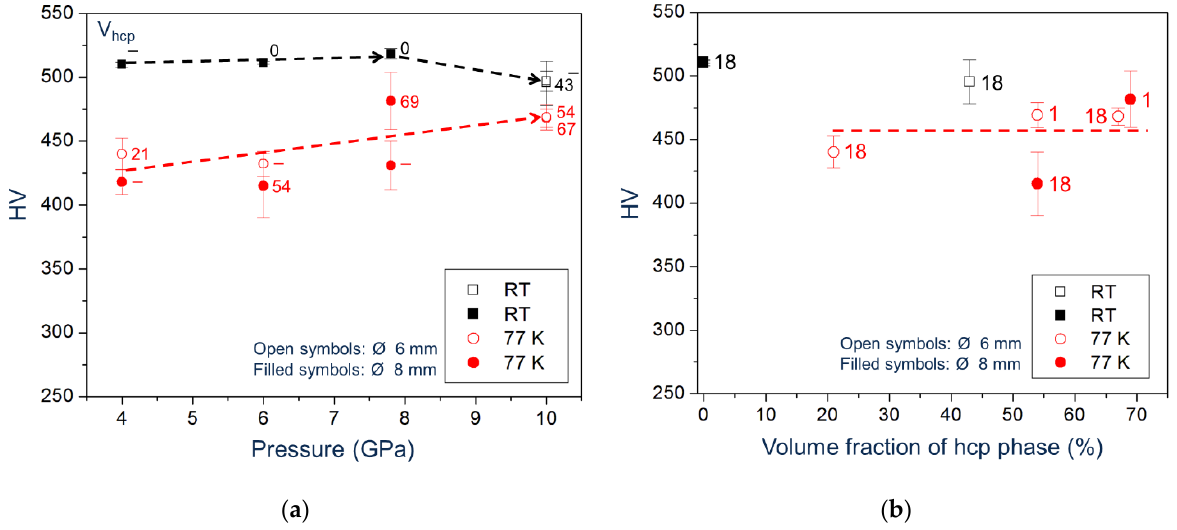
Figure 16. Microhardness measured at RT versus pressure ( a ) and volume fraction of hcp phase ( b ) of samples HPT-deformed at RT and LNT ( γ ≈ 100). The volume fraction of hcp phase ( a ) and time of phase analysis after HPT (in months) ( b ) is given.